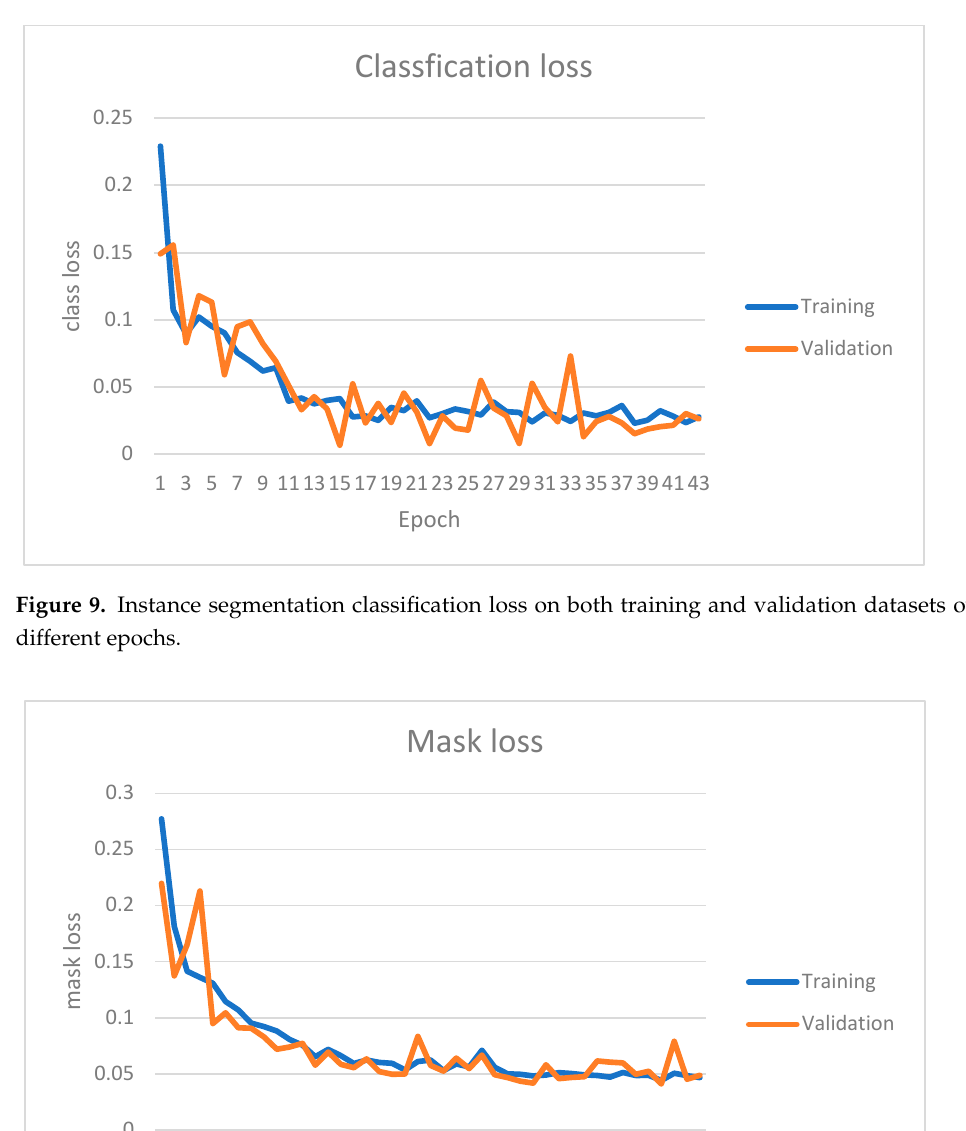
Figure 8. Instance segmentation bounding box loss on both training and validation datasets over different epochs.